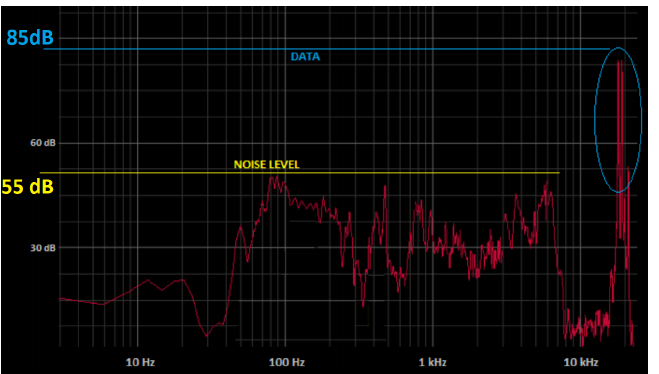
Figure 7. Sound Spectrum of the environment with transmitted signal in the inaudible band, and comparison with the average noise level.